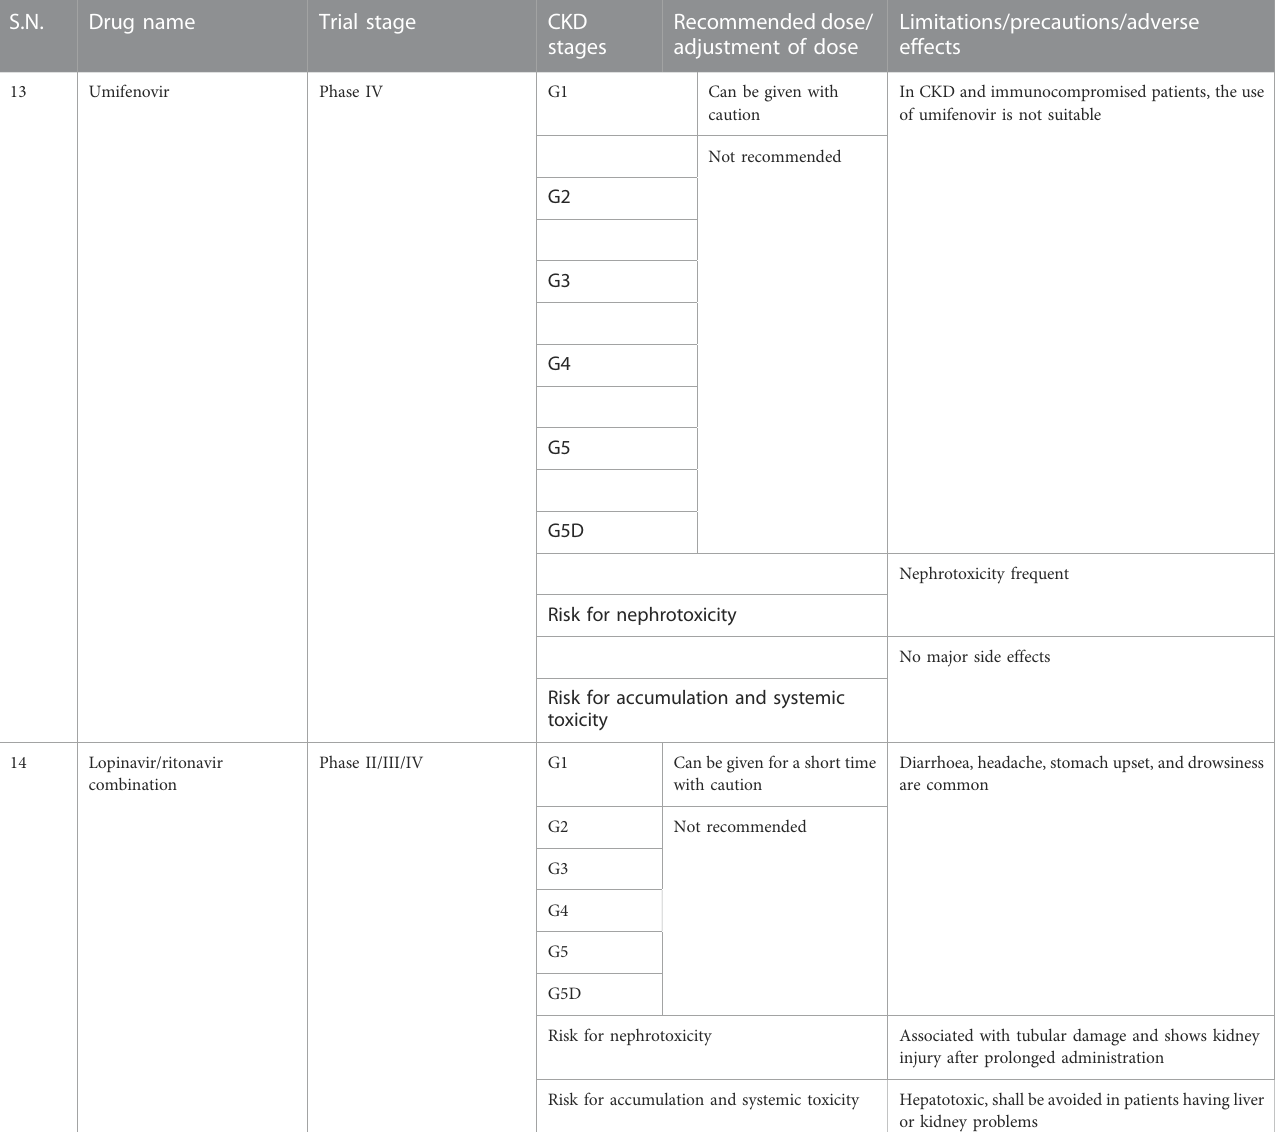
TABLE 1 ( Continued ) Recommendations for dosing and precautions of antivirals in COVID-19 patients with different stages of CKD.